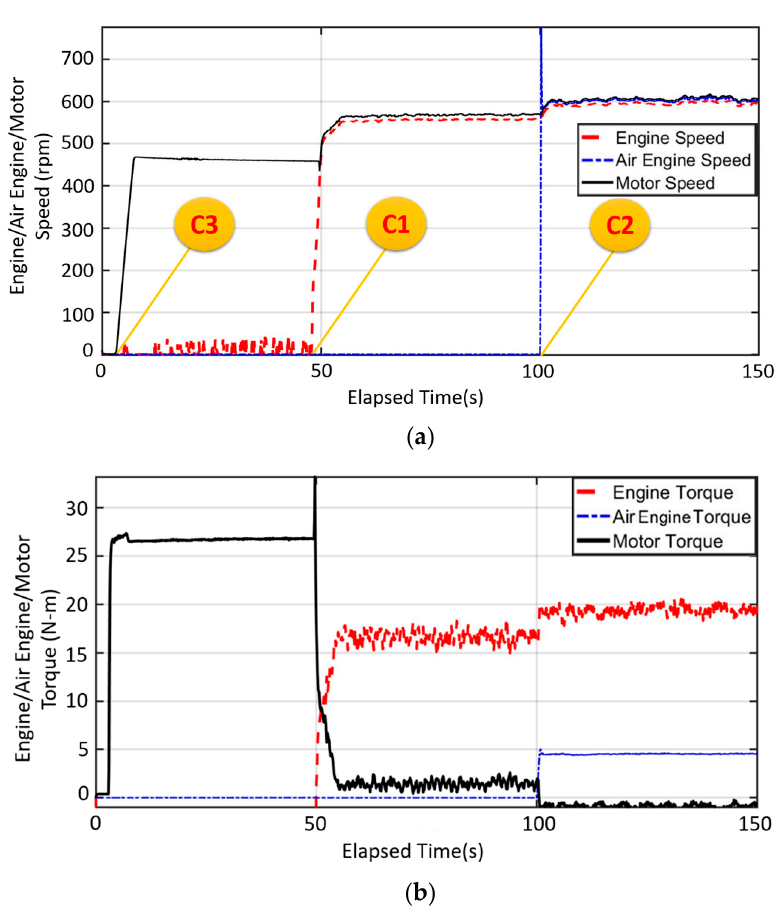
Figure 16. Engine/motor/air engine hybrid mode: ( a ) speeds; ( b ) torque . Figure 16. Engine / motor / air engine hybrid mode: ( a ) speeds; ( b )